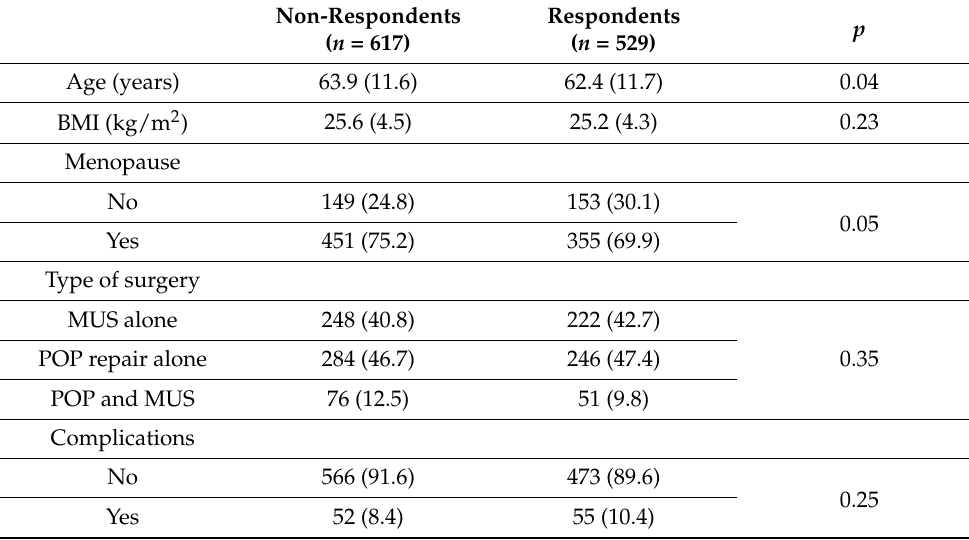
Table 1. Respondents’ and non-respondents’